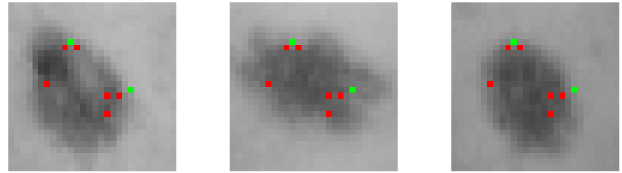
Figure 14. Samples belonging to the “malignant” class, activating the same rule.